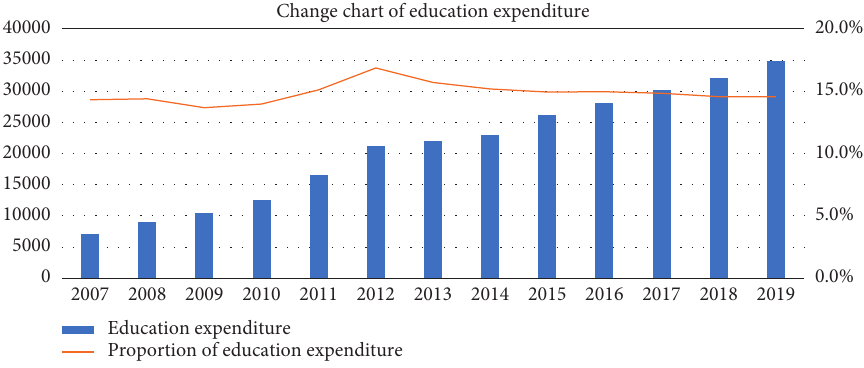
Figure 3: Trends of Education expenditure in China from 2007 to